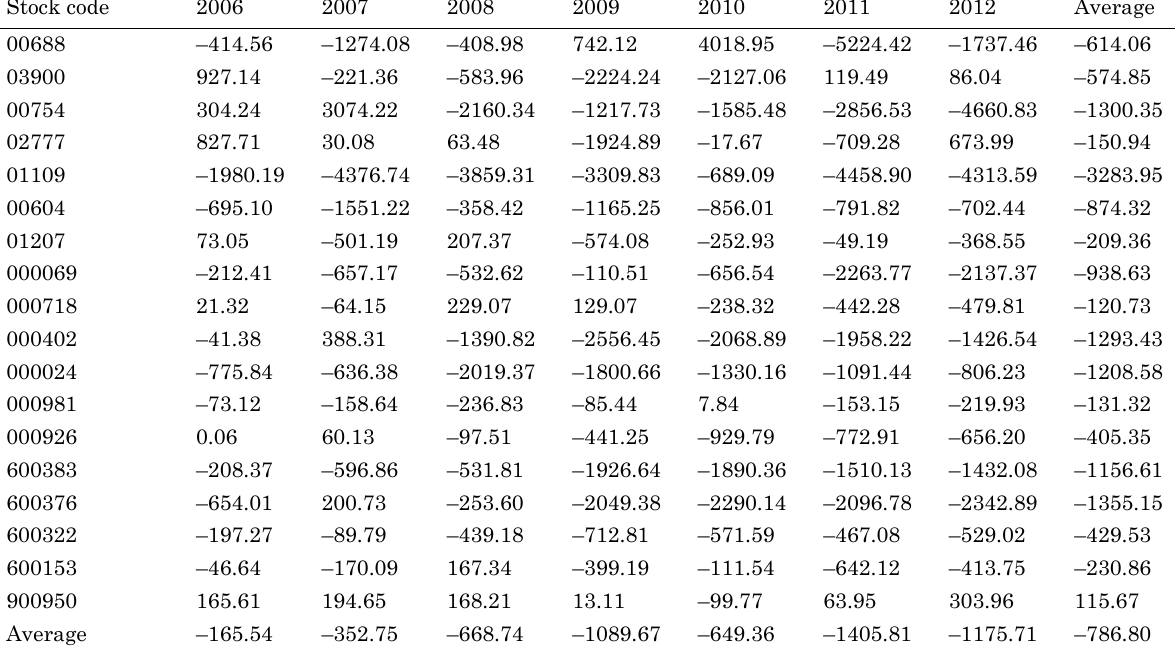
Table 3. EVA of the 18 mainland property companies during the period 2006–2012 (unit: million RMB) Stock